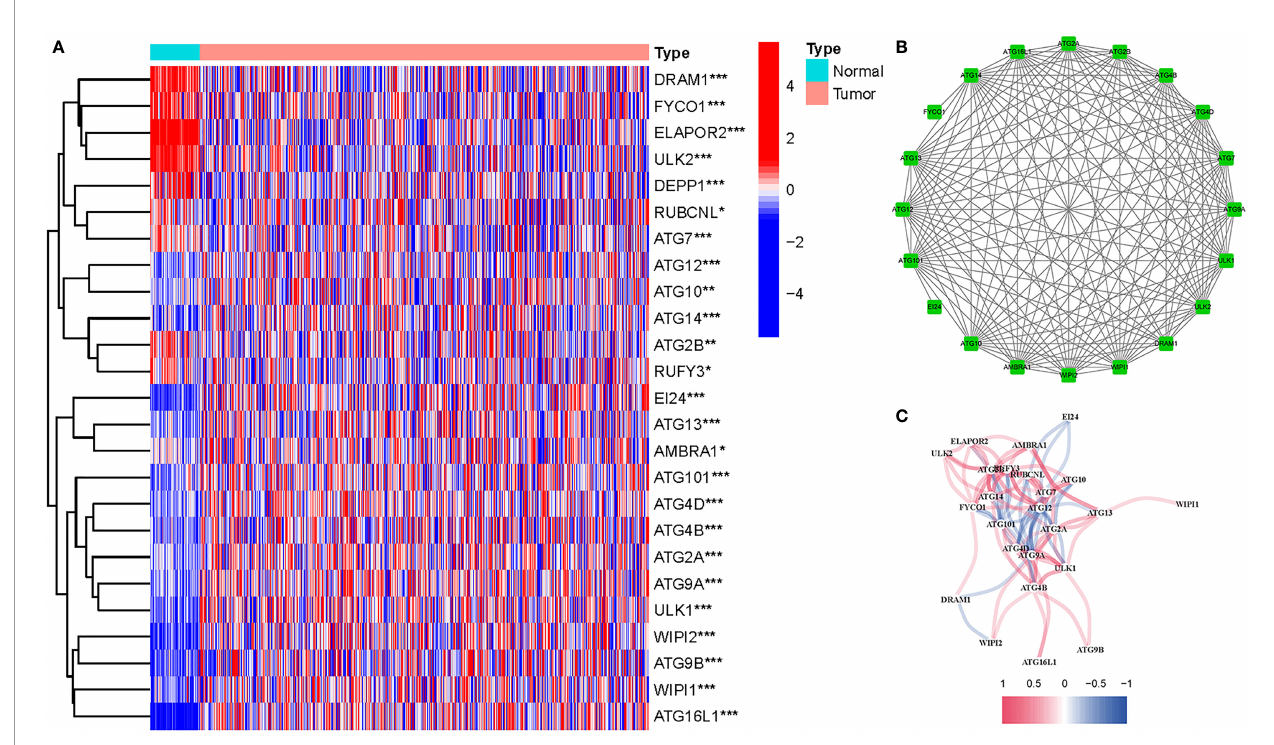
FIGURE 2 | Expressions of the 25 genes participating in autophagy and the interactions among them. (A) Heatmap (green: low expression level; red: high expression level) of the genes participating in autophagy between the normal (N, brilliant blue) and the tumor tissues (T, red). P values were shown as *P <